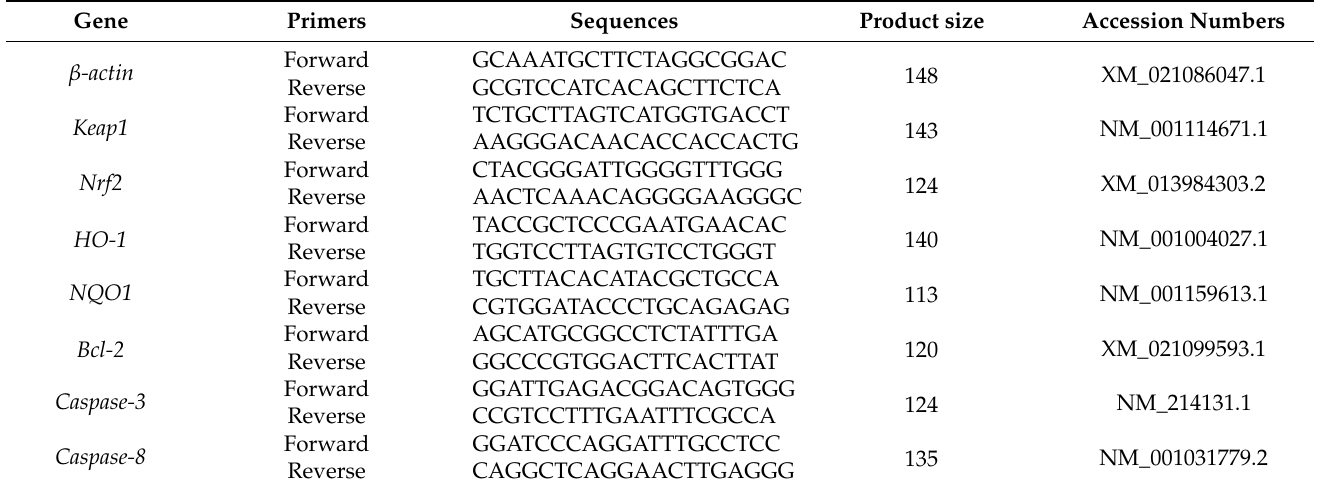
Table 2. Primer sequences